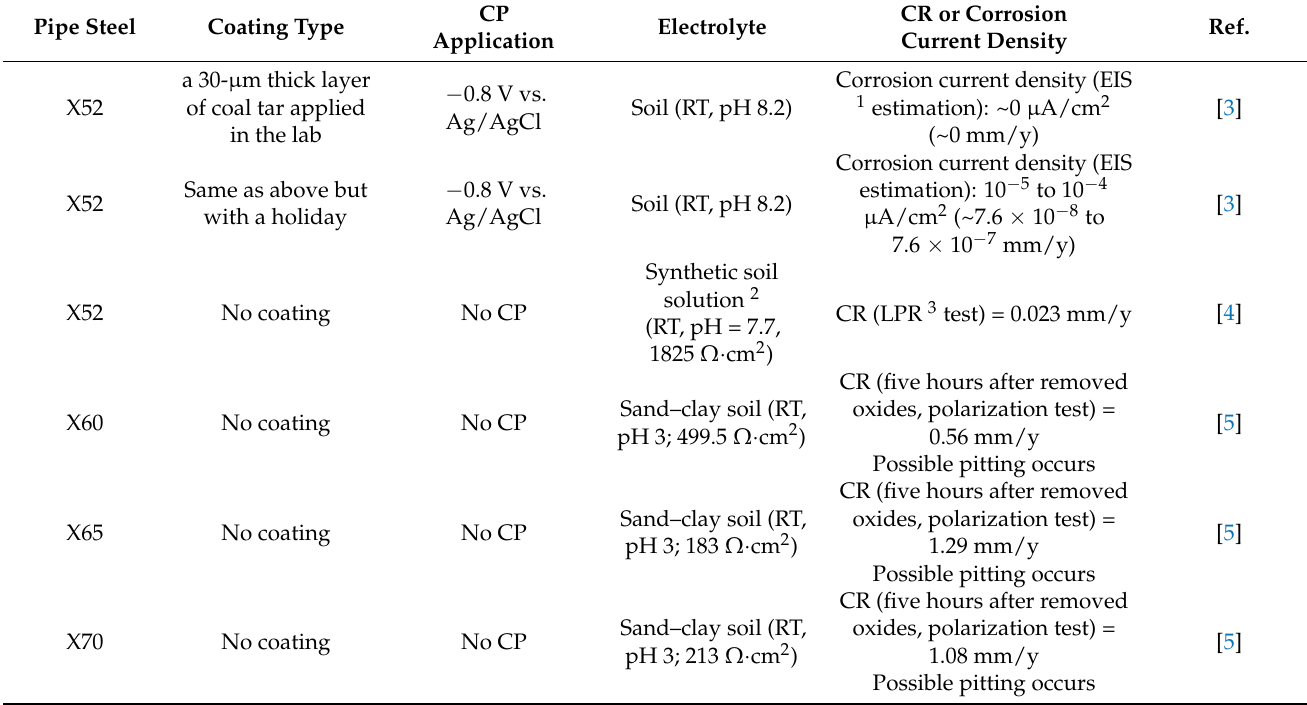
Table 1. CR of different pipe steels with and without a